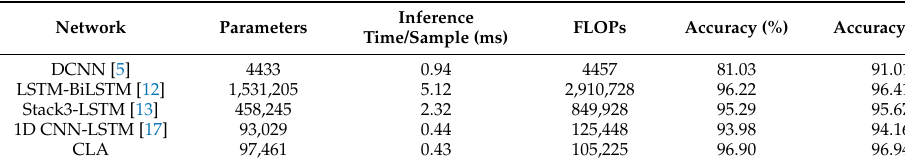
Table 4. Performance comparison of the literature networks. Network Parameters